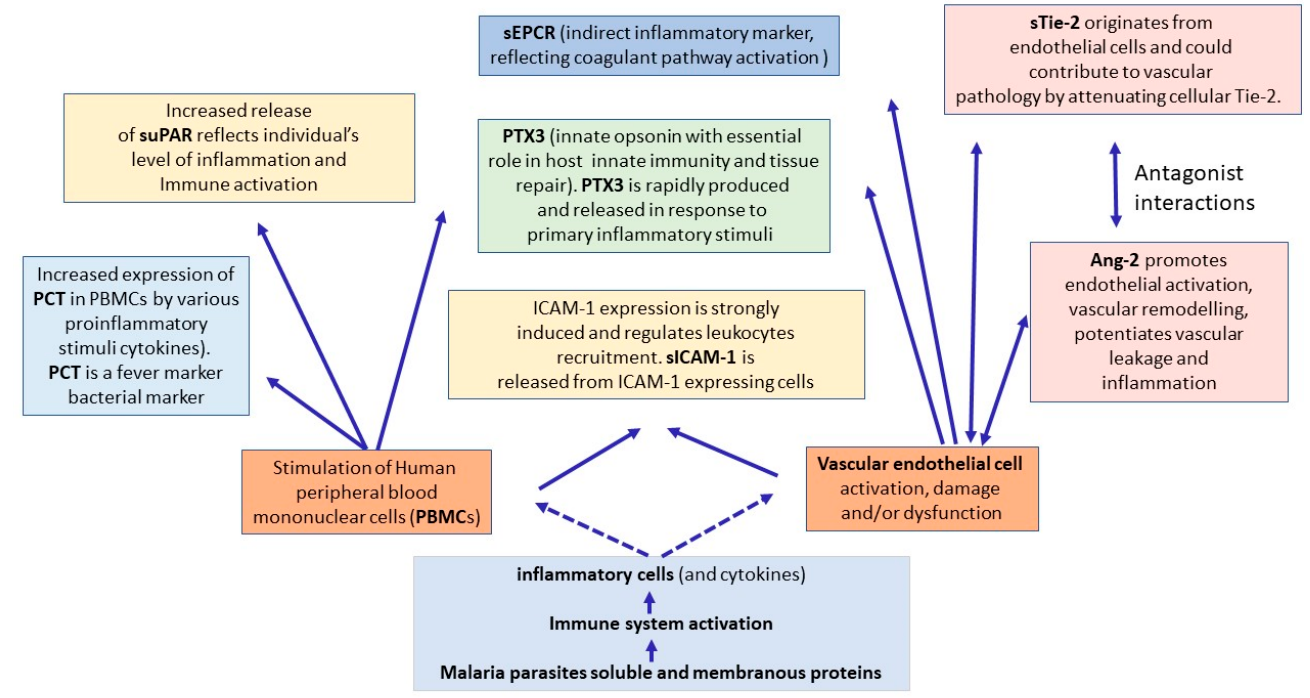
Figure 7. Clustering diagram showing the interaction between the molecules assessed in this study in the context of malaria